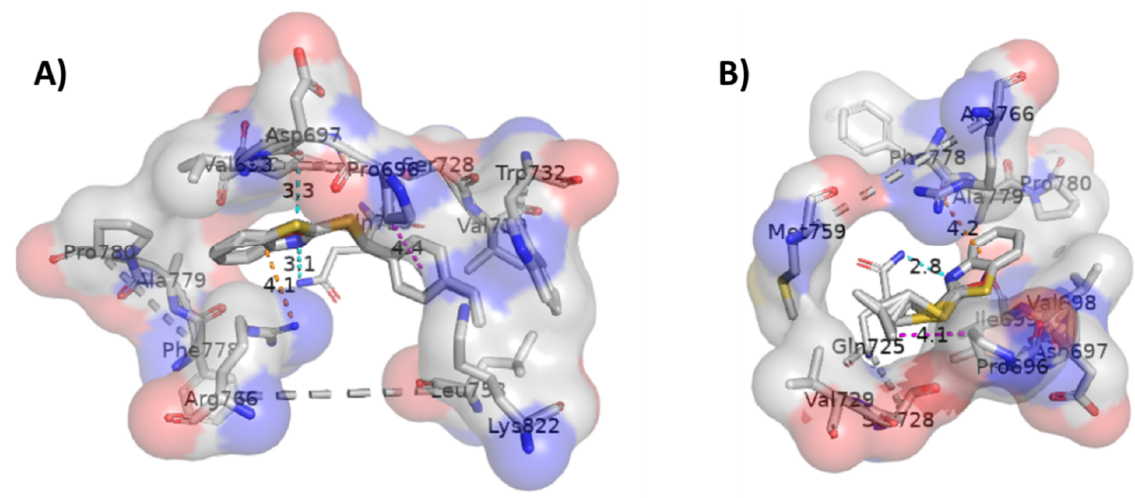
Figure 3. Interactions maps between receptor Pr and molecules ( A ) BTA-1 , BZM-2 , and BOX-3 ( B ) BTA-4 , BZM-5 , and BOX-6 . Cyan dashed lines are hydrogen bonds, magenta are pi–alkyl interactions, and yellow are pi–sulfur interactions.